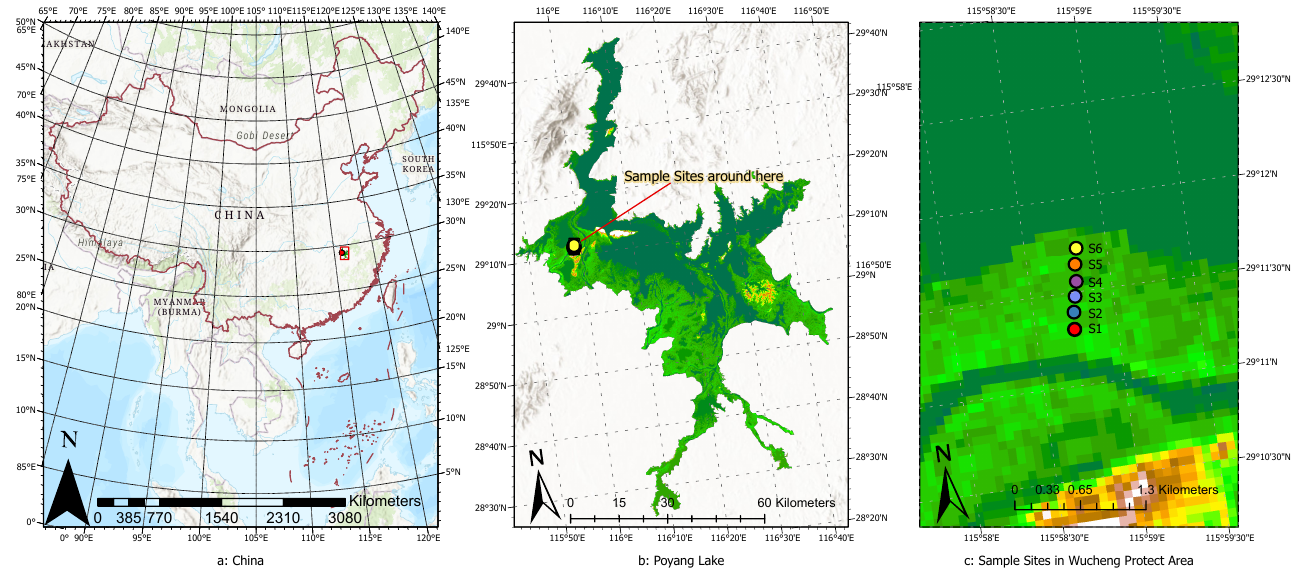
Figure 1. Geographic locations of sampling points. The red rectangle in the ( a ) part represents the ( b ) part area. S1 to S6 represent sampling point 1 to sampling point 6 . Because the map resolution is too low, so we extended the distance from every sample point and the actual distances are smaller than those on the map ( c ) part. They are closer to the middle of the 6 points.